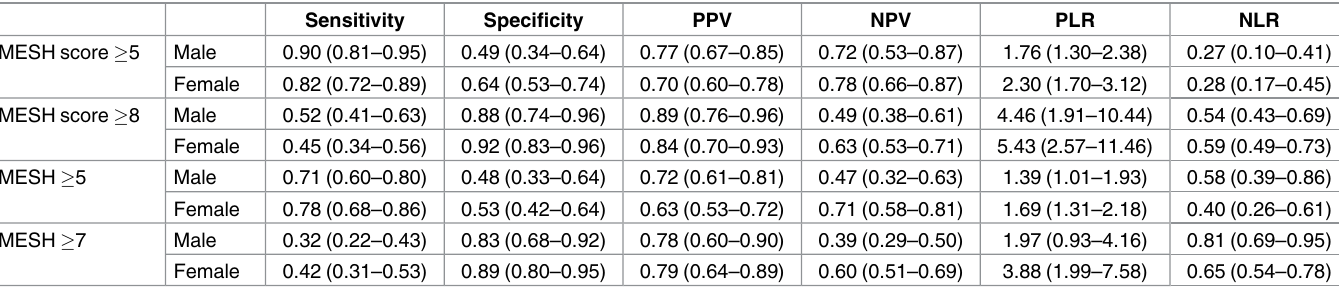
Table 5. Performance of the MESH score and the Alvarado score according to gender * .